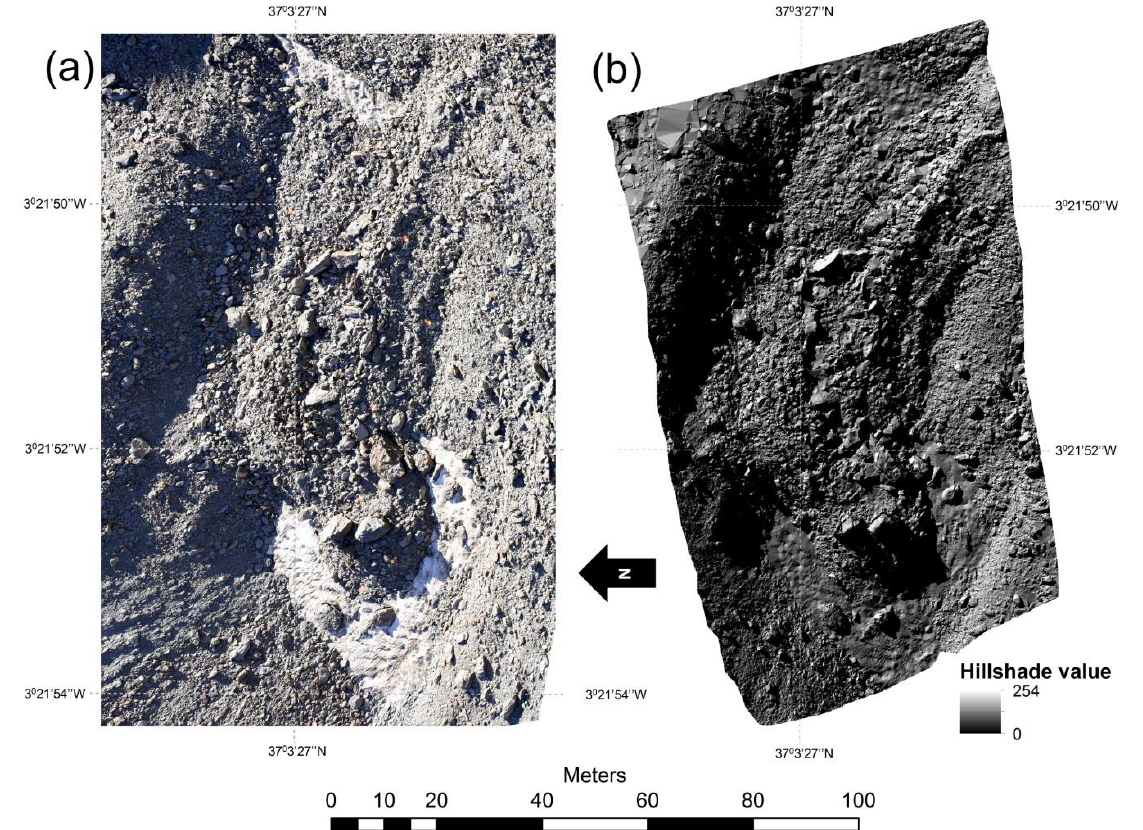
Figure 6. Correspondence between ( a ) an orthorectified photograph of the Corral del Veleta rock glacier captured for this research and ( b ) the hillshade model calculated for the same date and